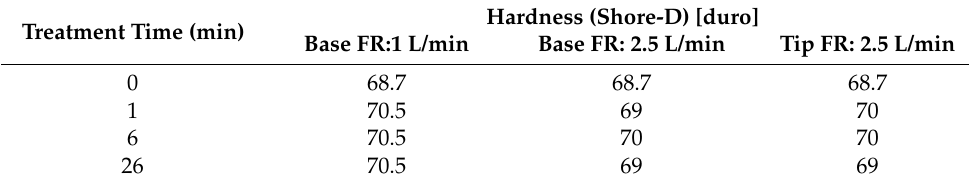
Table 2. Maximum hardness readings.